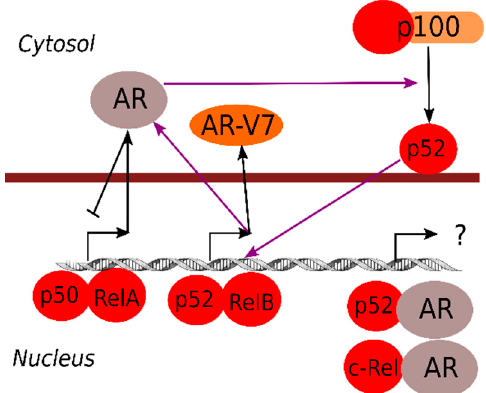
Figure 2. Schematic overview of crosstalk between AR and various NF- κ B family members. Both p50/RelA and p52/RelB can drive AR expression, and p52/RelB can also drive expression of an androgen-independent AR splice variant (AR-V7). AR stimulation, in turn, represses canonical (p50/RelA) but promotes non-canonical (p52/RelB) NF- κ B signaling. A potential feed-forward loop between AR and non-canonical NF- κ B signaling is highlighted with purple arrows. AR can also act as a transactivator in complex with NF- κ B family members, but the significance of the transcripts downstream of these hybrid transcription factors is currently unknown.